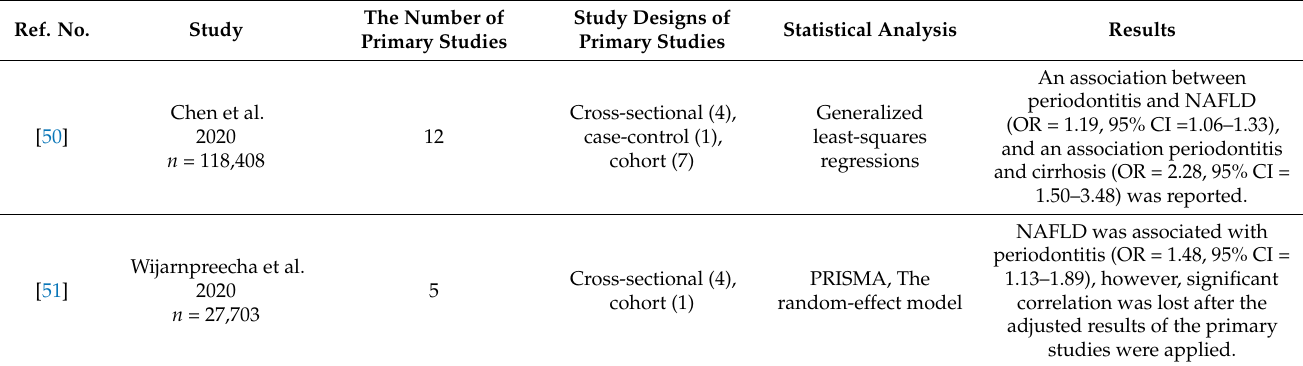
Table 3. Meta-analysis regarding the relationship between NAFLD and periodontal disease. The Number of Study Designs of Ref. No. Statistical Analysis Results Primary Studies Primary Studies An association between periodontitis and NAFLD Cross-sectional (4), Generalized (OR = 1.19, 95% CI =1.06–1.33), 12 case-control (1), least-squares and an association periodontitis cohort (7) regressions and cirrhosis (OR = 2.28, 95% CI = 1.50–3.48) was reported. NAFLD was associated with periodontitis (OR = 1.48, 95% CI = Cross-sectional (4), PRISMA, The 1.13–1.89), however, significant cohort (1) random-effect model correlation was lost after the adjusted results of the primary studies were